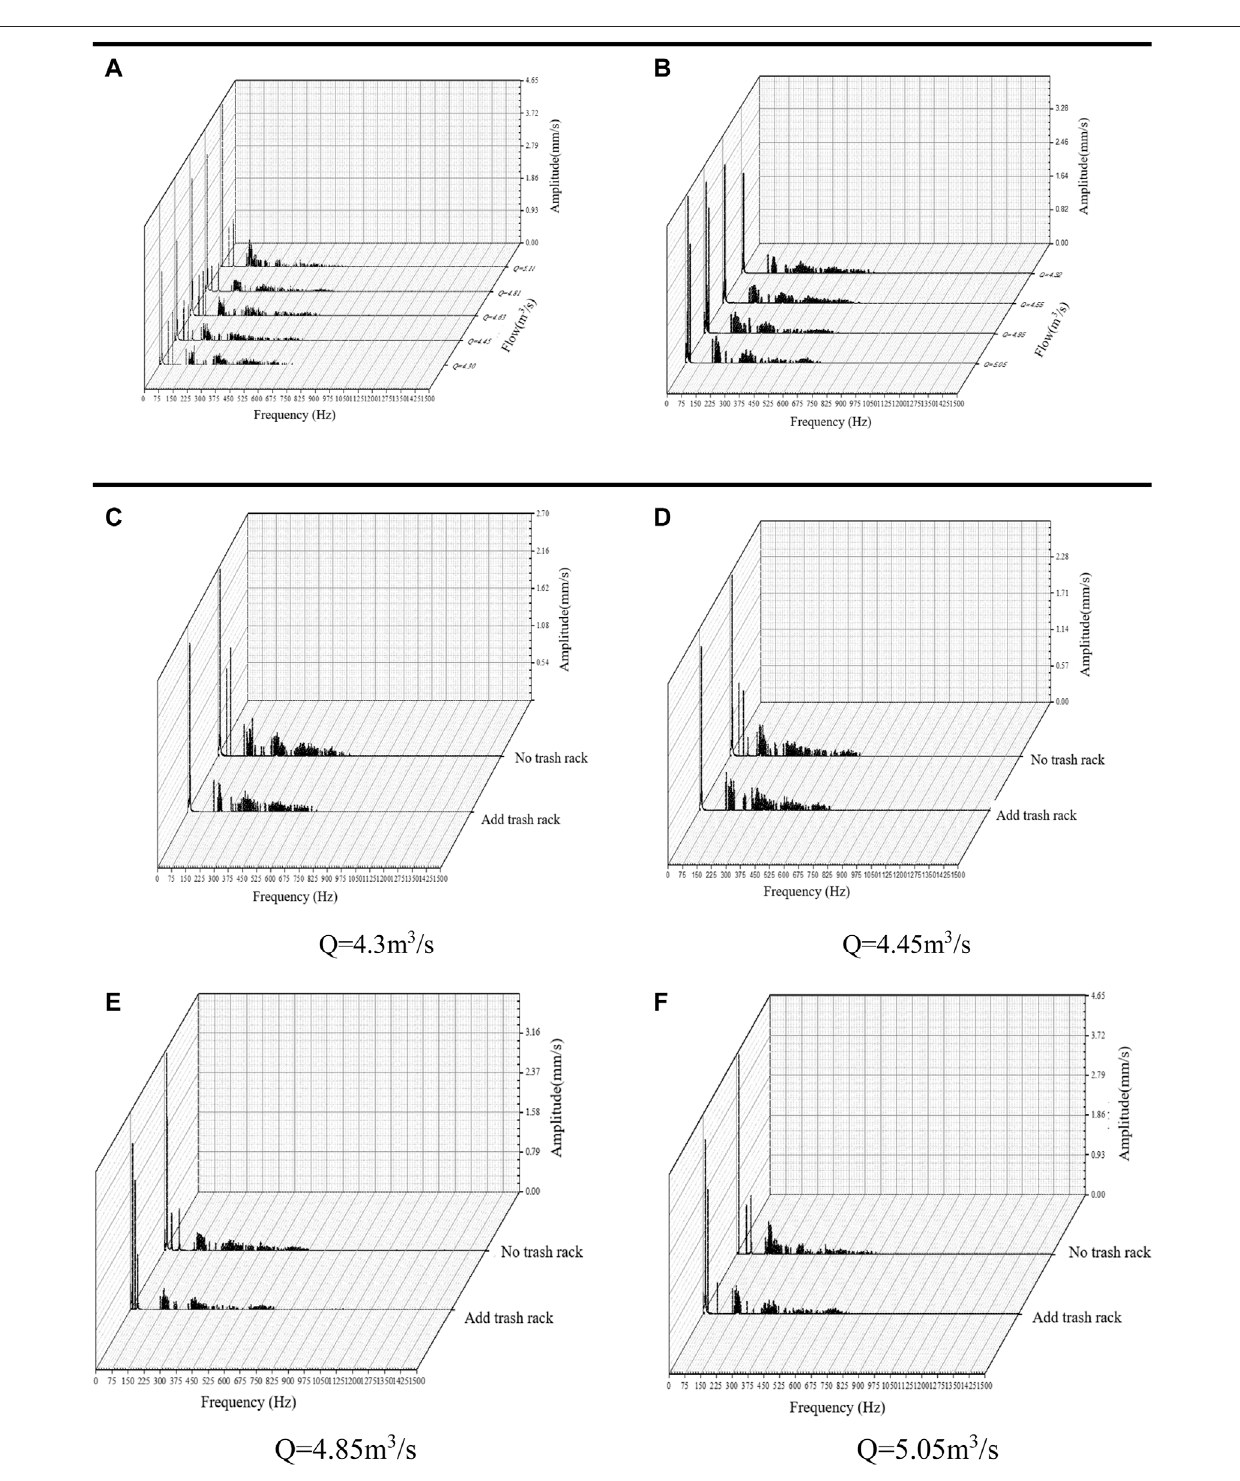
FIGURE 11 | Vibration velocity distribution of P1 monitoring point. ( (A) Vibration velocity distribution of P1 without the trash rack. (B) Velocity frequency domain distribution of P1 with the trash rack. (C) – (F) Distribution of velocity frequency domain for different fl ow conditions at P1 (C) Q = 4.3 m 3 /s, (D) Q = 4.45 m 3 /s, (E) Q = 4.85 m 3 /s, and (F) Q = 5.05 m 3 /s).